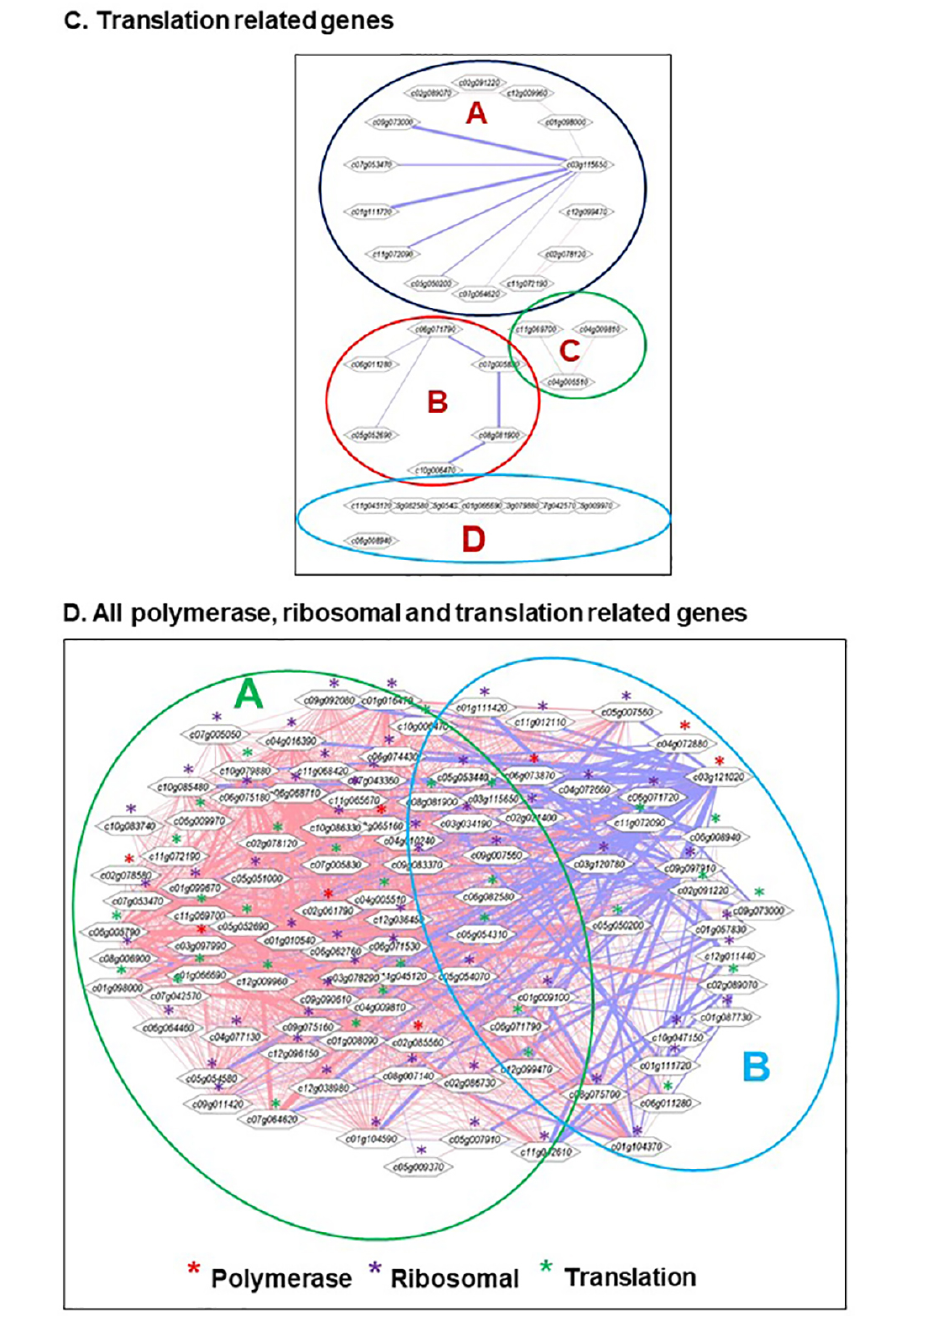
Figure 4. Cytoscape presentation of Pearson correlation coe ffi cients among transcript levels of RNA polymerases ( A ), ribosomal biogenesis-related protein genes ( B ), translation machinery-related protein genes ( C ) and combined polymerase , ribosomal and translation genes ( D ). To determine the Pearson correlation among the polymerase, ribosomal and translation related genes, the FPKM of selected 9 polymerase (Table S4), 57 ribosomal (Table S6) and 31 translation (Table S5) were combined in a single Excel sheet and Pearson coe ffi cient determined (Table S7). These correlations were visualized by Cytoscape (Figure 4D). Only correlation coe ffi cients that exhibited values > 0.9 and < − 0.9 were used to determine the Metscape network. Networks were constructed using the Cytoscape-Metscape correlation-based build network program [24]. Red and blue edges indicate positive and negative correlations, respectively. The thickness of edges is proportional to relative correlation coe ffi cient. The annotation of genes is the same as in Table S4. The values for all correlations are shown in Tables S5 and